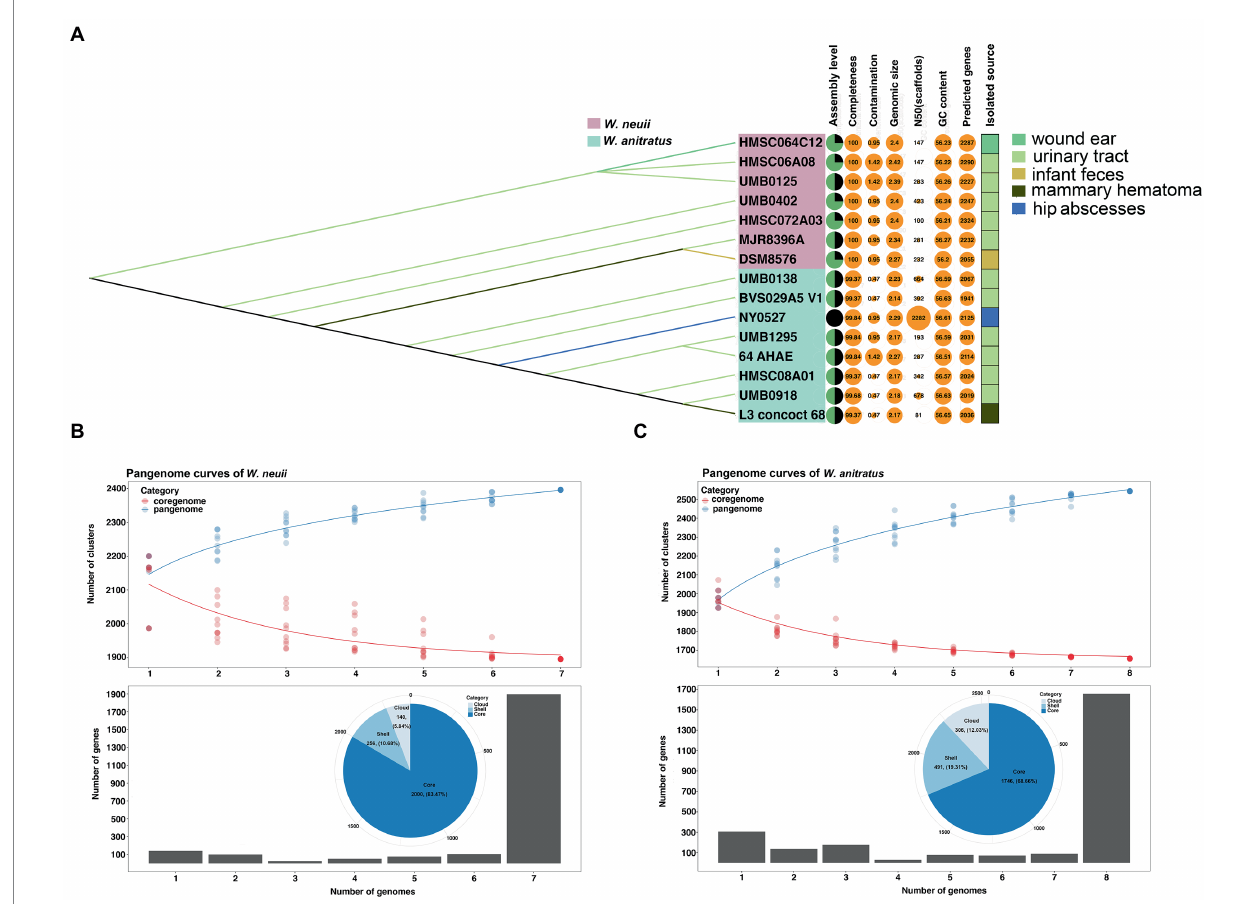
FIGURE 3 The comparison of pangenomic features between W. neuii and W. anitratus strains. (A) Characterization of the general genomic feature and isolation source. (B,C) Pangenomic features of W. neuii and W. anitratus strains.